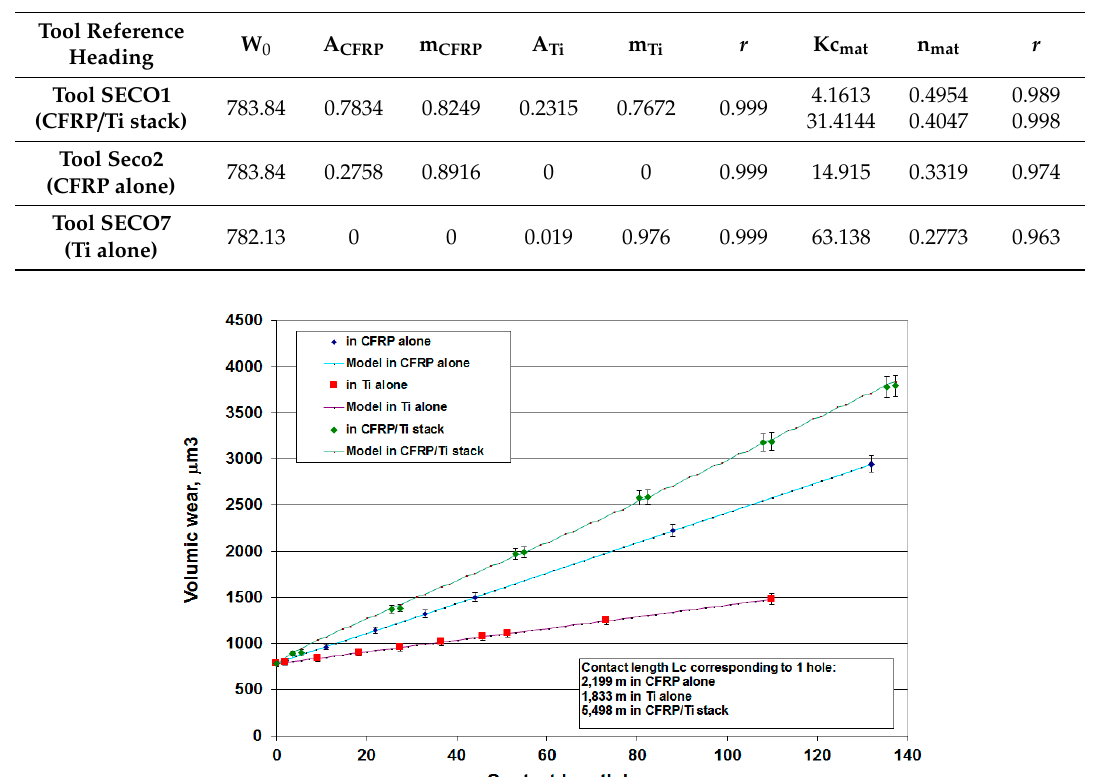
Figure 23. Evolution of the axial load in the different configuration and assuming for CFRP/Ti alloy stacks that 90% of the wear is produced in the CFRP and 10% in the Ti alloy. 7. Discussion